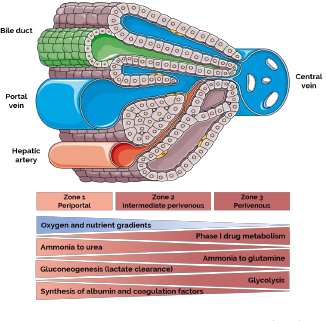
Figure 1. Liver metabolic zonation. Image adapted from Servier Medical Art